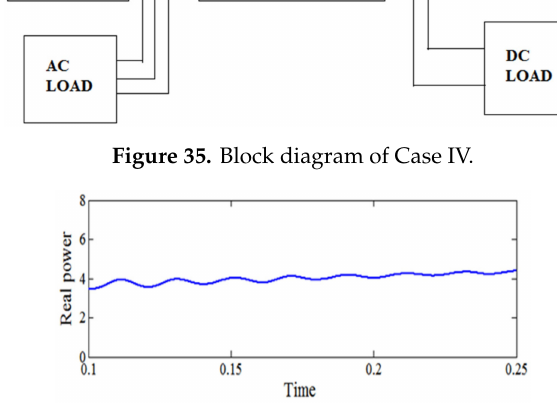
Figure 36. Real power from generation.